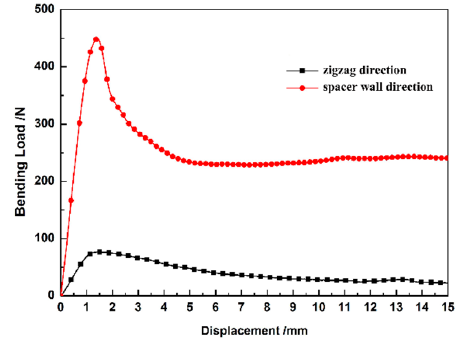
Figure 4. Bending load–displacement curves of zigzag-shaped 3D woven spacer composites with different